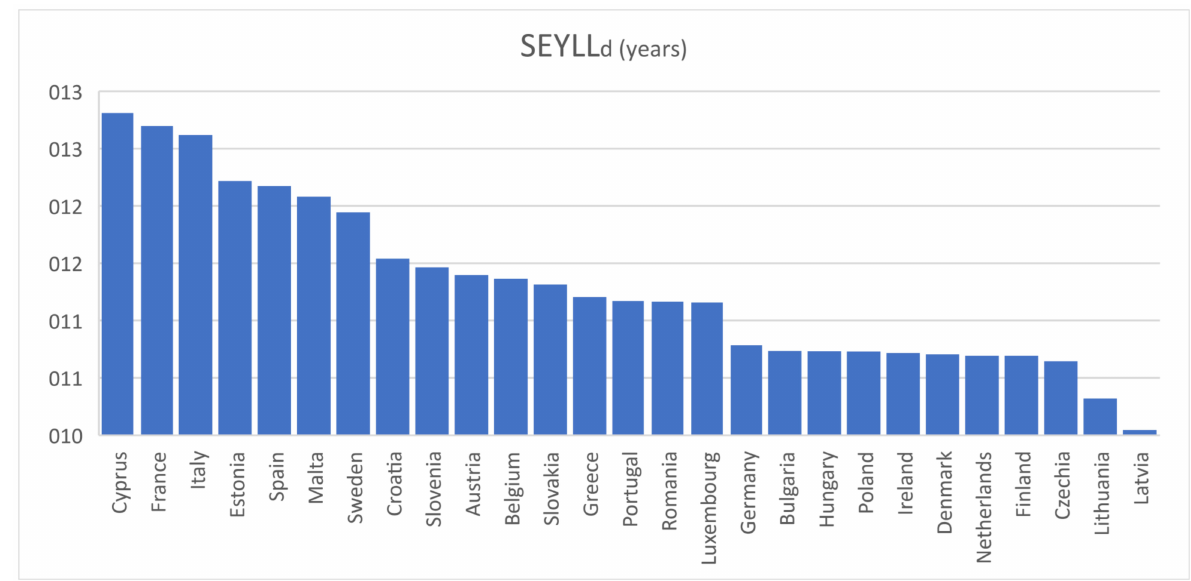
Figure 2. SEYLL d (in years) for the 27 EU